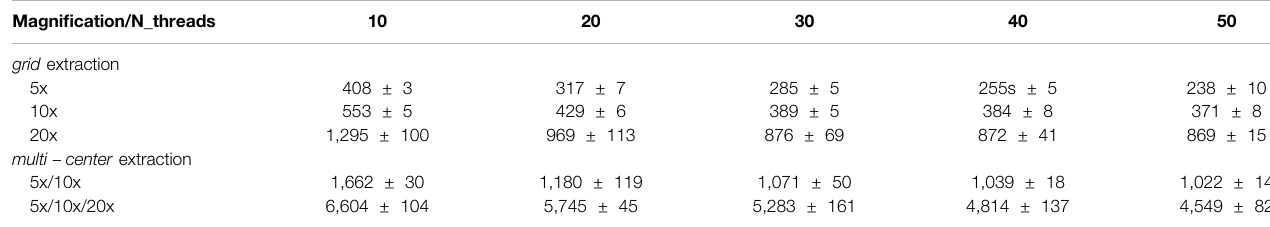
TABLE 2 | Time needed to extract the patches (in seconds), varying the amount of threads, using the grid extraction method (above) and using the multi − center method (below). The method is evaluated on colon dataset (148 WSIs). The number of patches extracted from each method is reported in Table 1 . Magni fi